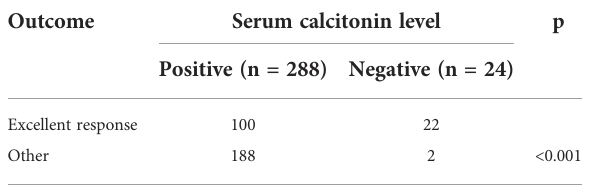
TABLE 3 Comparison of treatment outcome between negative and positive